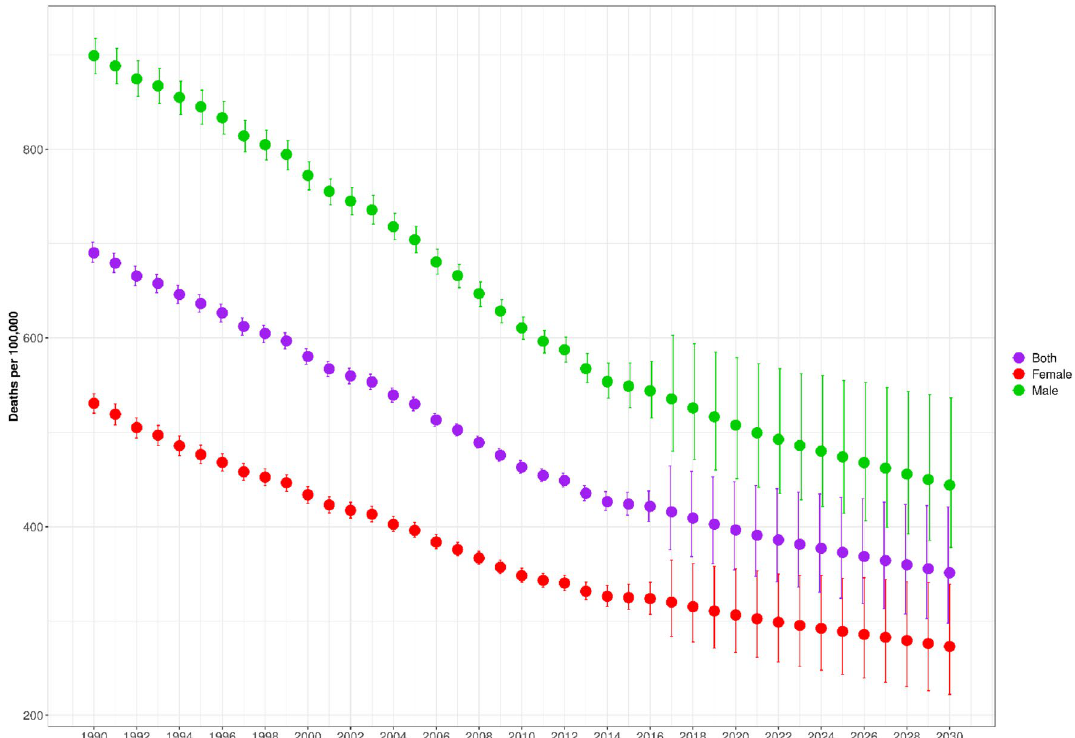
Figure 1. Death rate (per 100,000) (age-standardised) from 1990 and projected changes to 2030, in both